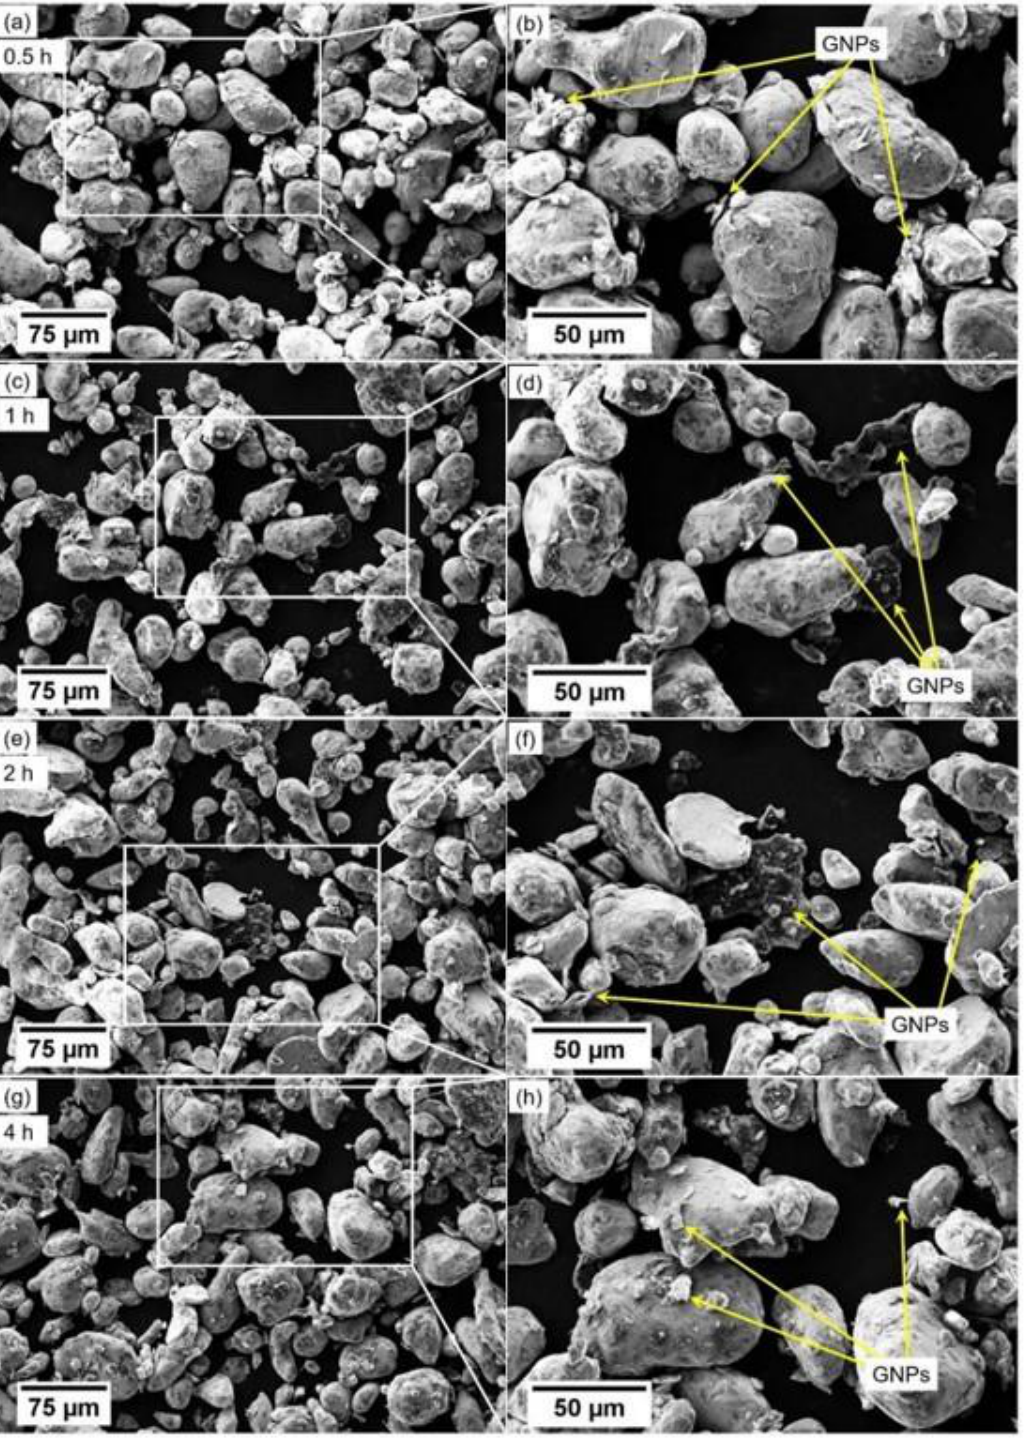
Figure 7. SEM images showing the morphological alteration of powders and the dispersion of agglomerated GNPs in the milled alloys for ( a , b ) 0.5 h, ( c , d ) 1 h, ( e , f ) 2 h and ( g , h ) 4 h with magnified images.